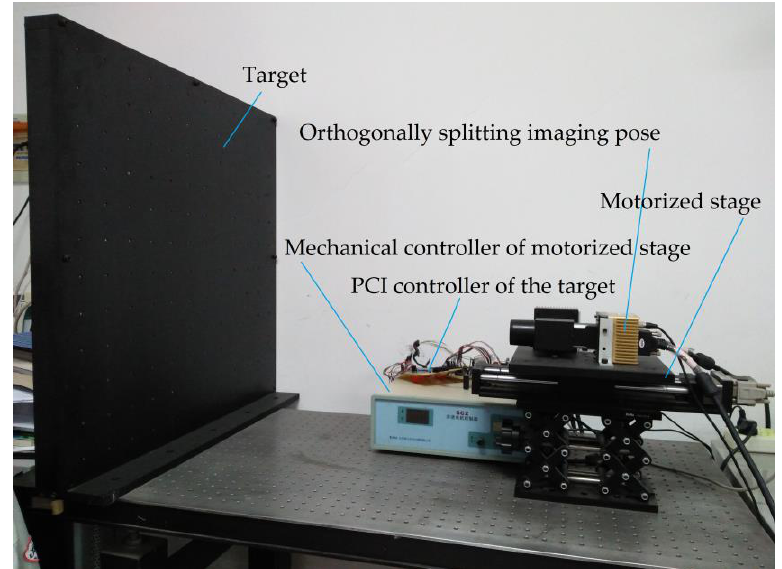
Figure 4. Experimental apparatus. Table 1. Apparatus parameters.